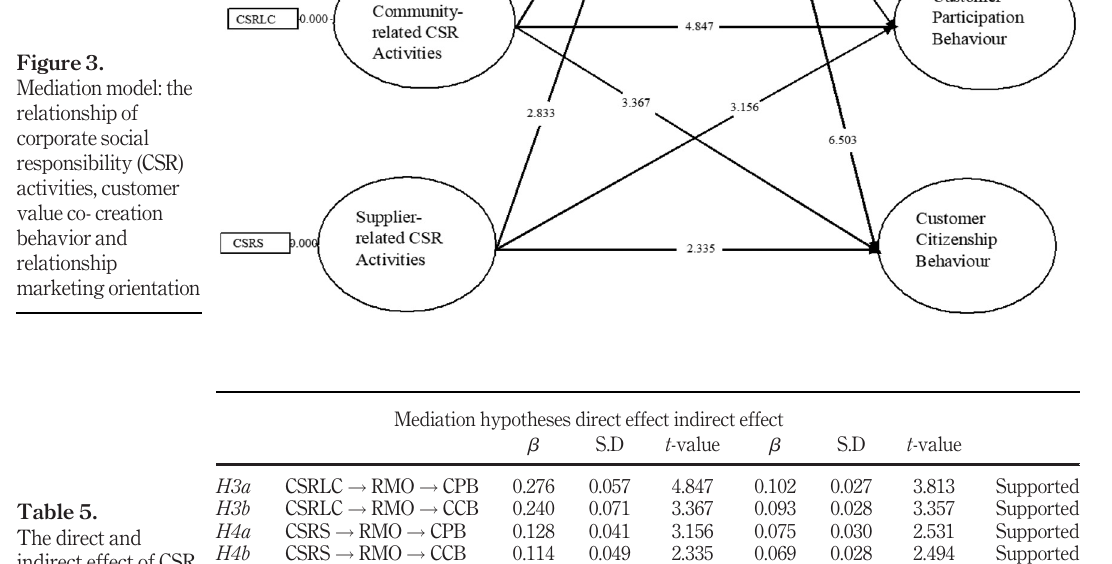
Table 5. The direct and indirect effect of CSR activities on customer value co- creation